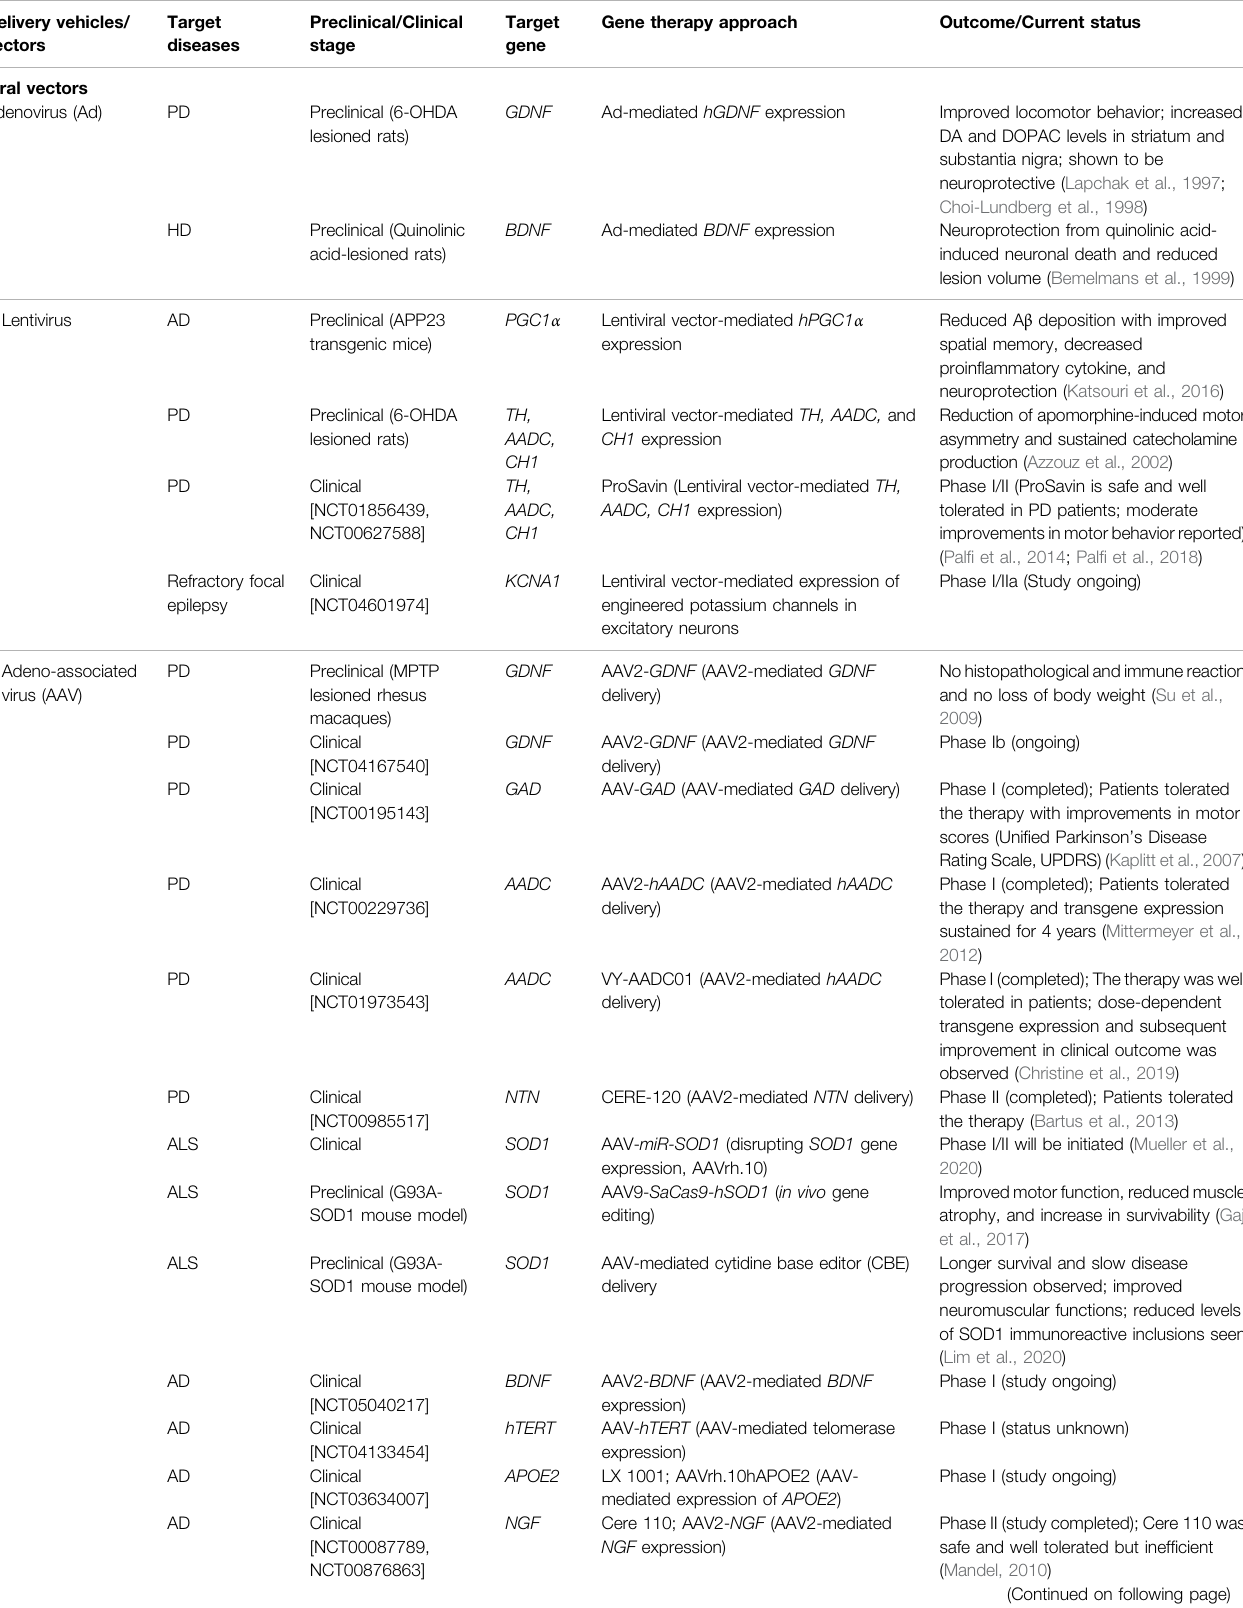
TABLE 1 | Gene therapy for neurological disorders using viral and non-viral